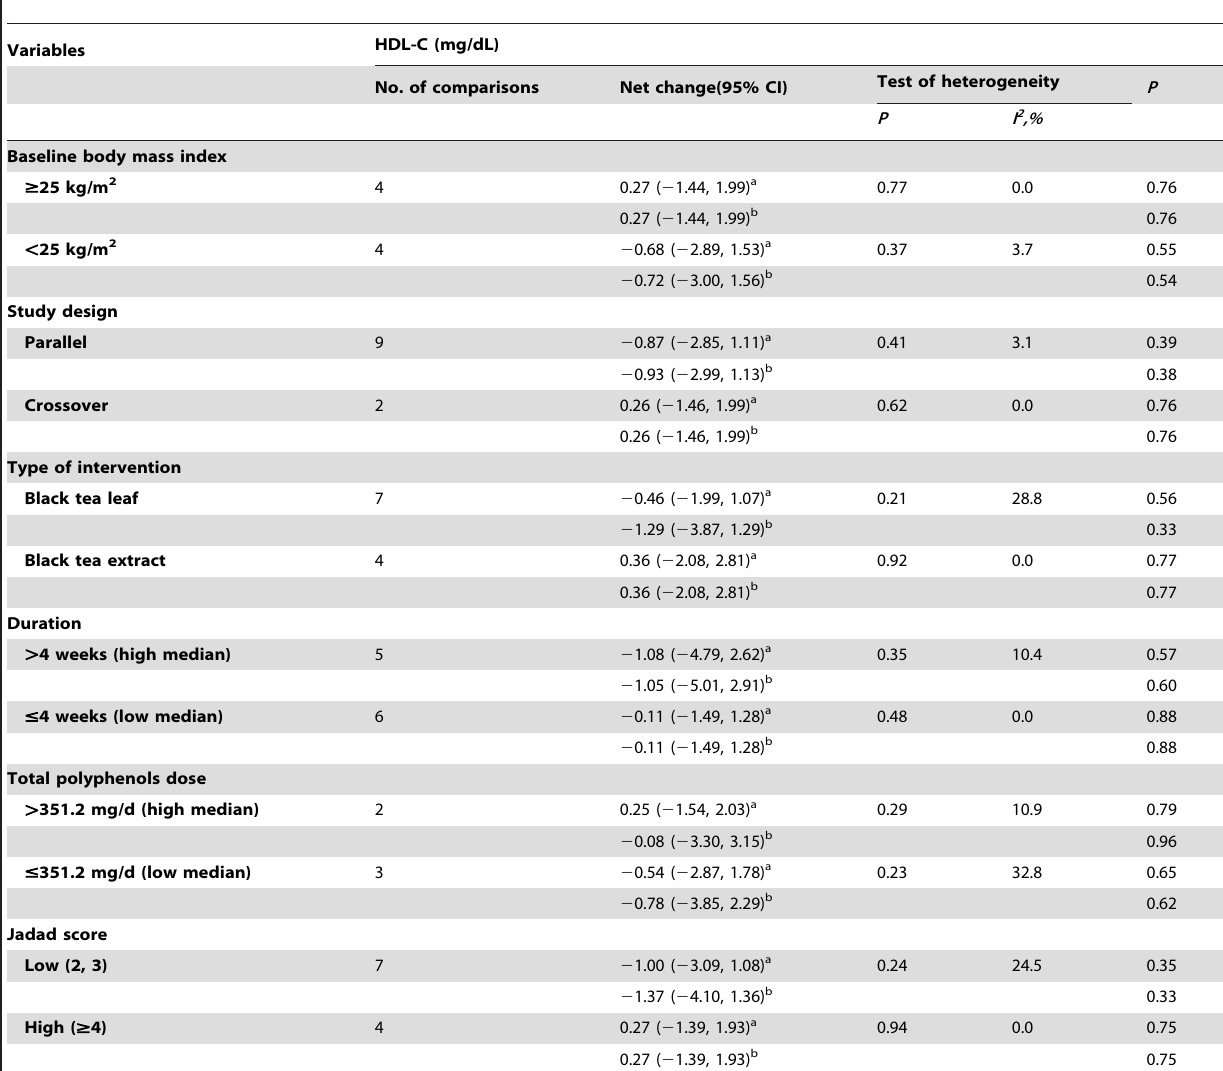
Table 3. Subgroup analyses of effect of black tea on HDL-C concentrations in healthy subjects stratified by previously defined study